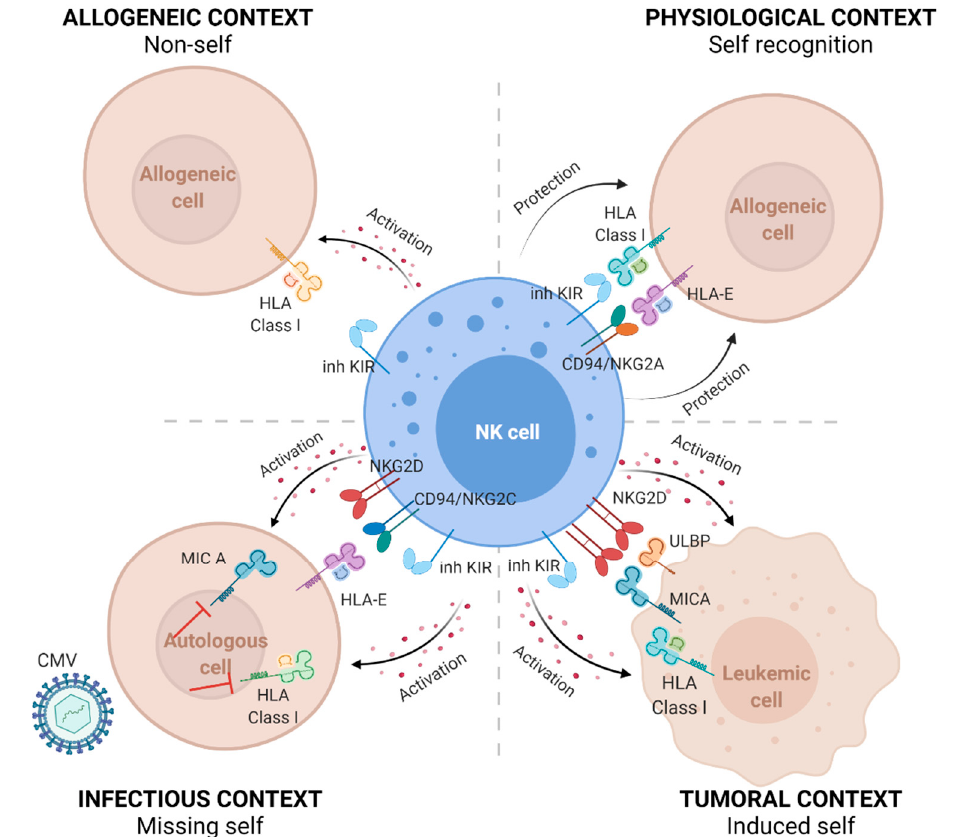
Figure 1. The natural cytotoxicity of NK cells is driven by the missing-self recognition. NK cells recognize healthy cells that express normal levels of HLA class I molecules and sense the absence of HLA class I molecules on allogeneic cells (non-self) or decreased expression of HLA class I molecules (missing-self) on tumor cells or virus-infected cells, as reported for the cytomegalovirus (CMV). Recognition of “self” mainly involves interactions between polymorphic inhibitory killer-cell immunoglobulin-like receptors (inh KIRs) and classical HLA class I molecules, as well as interactions between the CD94/NKG2A heterodimer and the nonclassical HLA-E molecule. The lack of interaction of inh KIRs with their HLA class I ligands or CD94-NKG2A with HLA-E induces the activation of NK cell lysis. In addition to KIR/KIR ligands, interactions of the induced MHC class I-like MICA ligand, ULBP ligand expressed on tumor cells, or the HLA-E molecule by respectively activating NKG2D or CD94/NKG2C receptors could activate NK cell lysis.